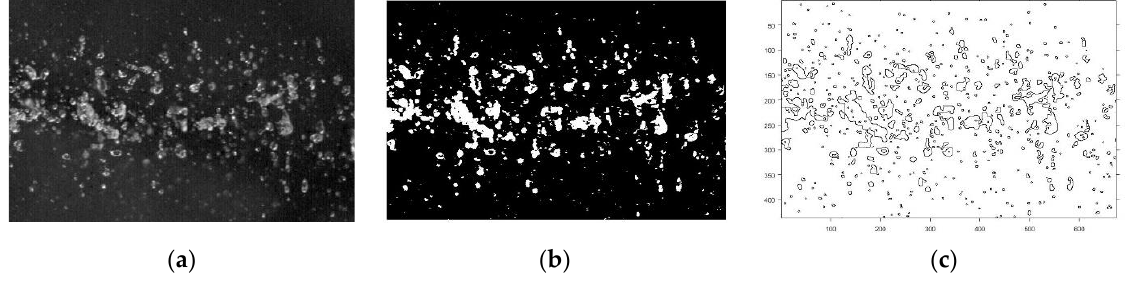
Figure 3. ( a ) The raw image, ( b ) binary image, and ( c ) droplets profile extraction, water droplet identification process using